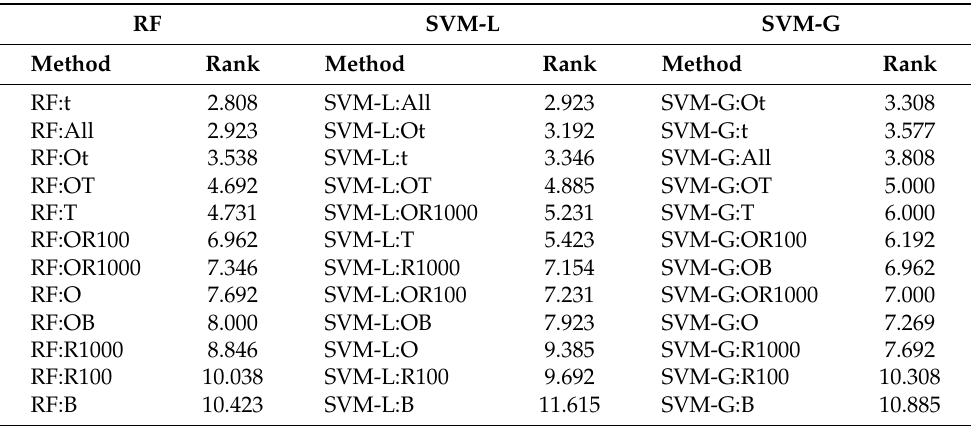
Table 9. Average ranks for each classification method, for difficult datasets.